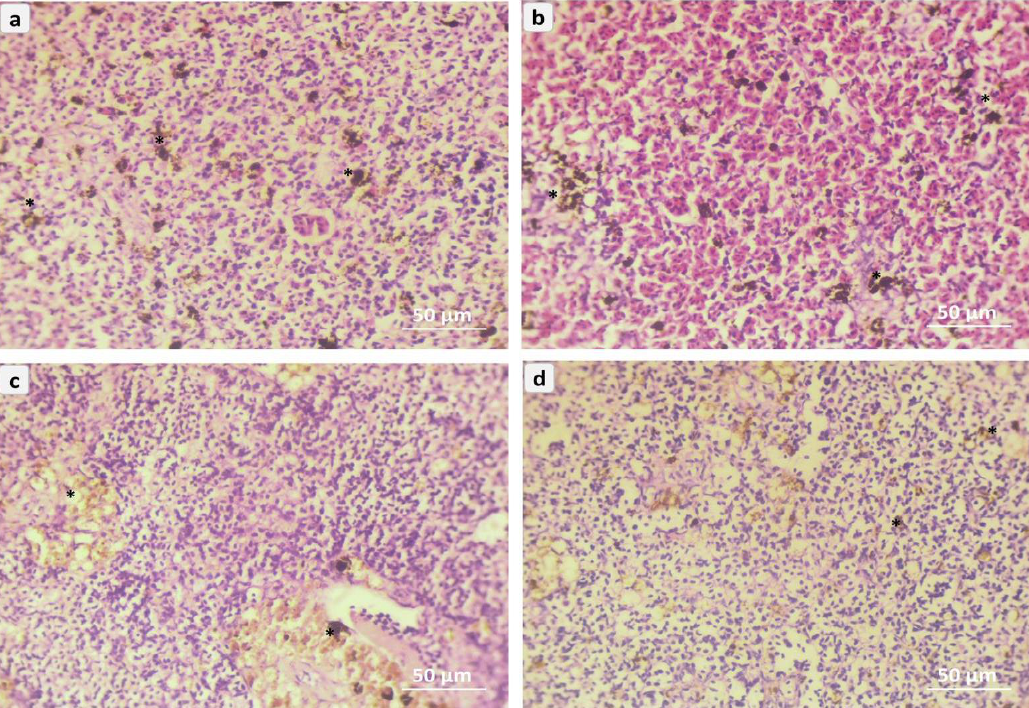
Figure 5. Representative micrograph of splenic sections of red tilapia ( Oreochromis sp . ) challenged with Aspergillus flavus , ( a ) → NC0, ( b ) → NC1, ( c ) → NC2, ( d ) → NC3. NC0: control diet; NC1: nanocurcumin 40 mg/kg diet; NC2: nanocurcumin 50 mg/kg diet; NC3: nano curcumin 60 mg/kg diet. Asterisks = melano inflammatory macrophages in between splenic trabecular tissues. (H&E, Bar = 50 µ